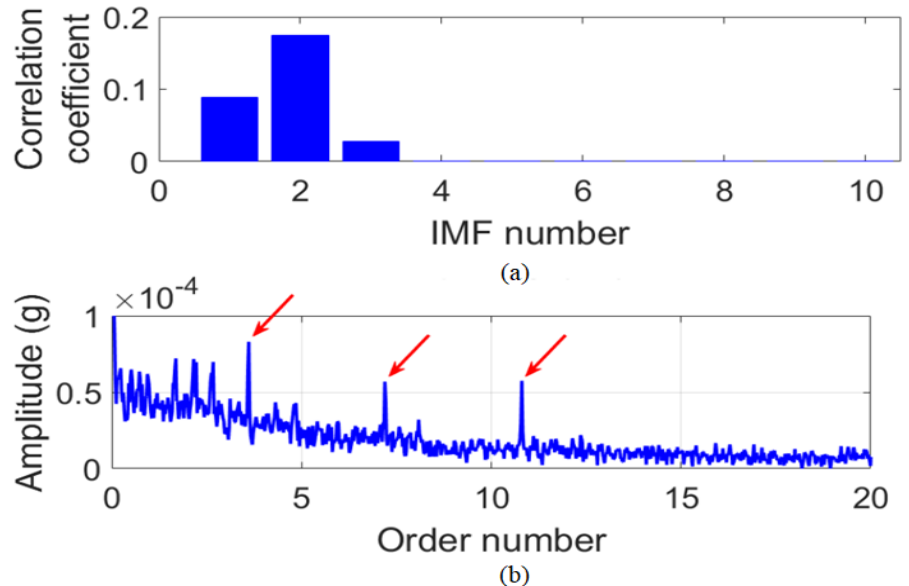
Figure 28. ( a ) IMF order of faulty generator bearing vibration signal ( b ) Sum of square error (SSE) distance variation to diagnose wind turbine main bearing fault (WTMB) detection at different inputs (red arrow shows the outer race fault order and its harmonics) [76].